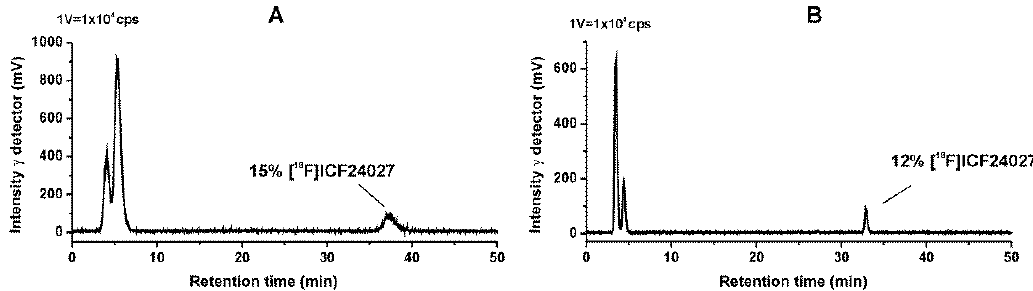
Figure 5. Representative radio chromatograms of a mouse brain sample of [ 18 F] ICF24027 30 min p.i.